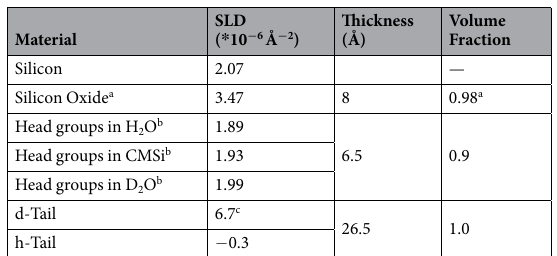
Table 1. Fitted SLD values of components of the lipid bilayer system and physical parameters obtained from fitting the 90:10 mol% DMPC/DMPS SLB prior to lipoprotein exposure. Typical errors are 1 Å for thickness, and 0.05 for volume fraction. a One silicon block was found to have a silicon oxide volume fraction of 0.83. b Calculated assuming 10 mol% PS heads, with exchangeable hydrogens. c Small deviation from the theoretical value for the SLD of d-tail (6.89 × 10 − 6 Å − 2 ) due to incomplete lipid deuteration, as confirmed by NMR spectroscopy (SI Fig.